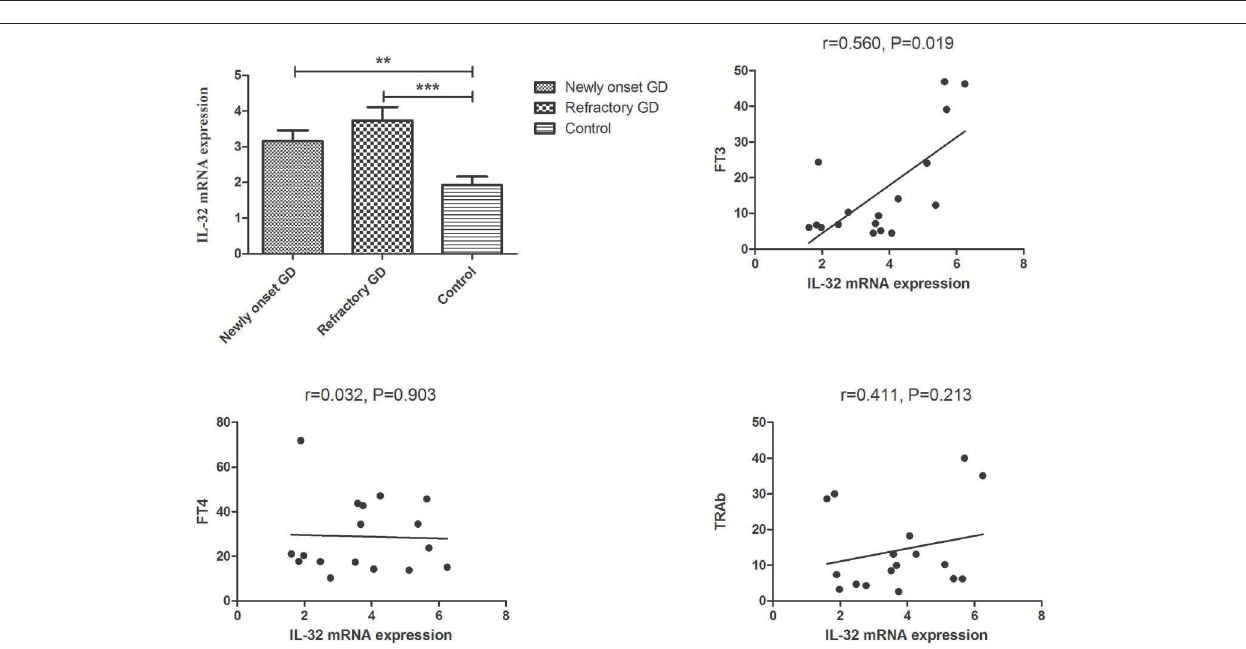
FIGURE 2 | Subgroup analysis of the expression of IL-32 mRNA in newly onset GD patients and refractory GD patients. IL-32 mRNA expression in both newly onset GD patients and refractory GD patients was significantly higher than that in controls; IL-32 mRNA expression in refractory GD patients was positively correlated with FT3. ** P < 0.01, *** P <